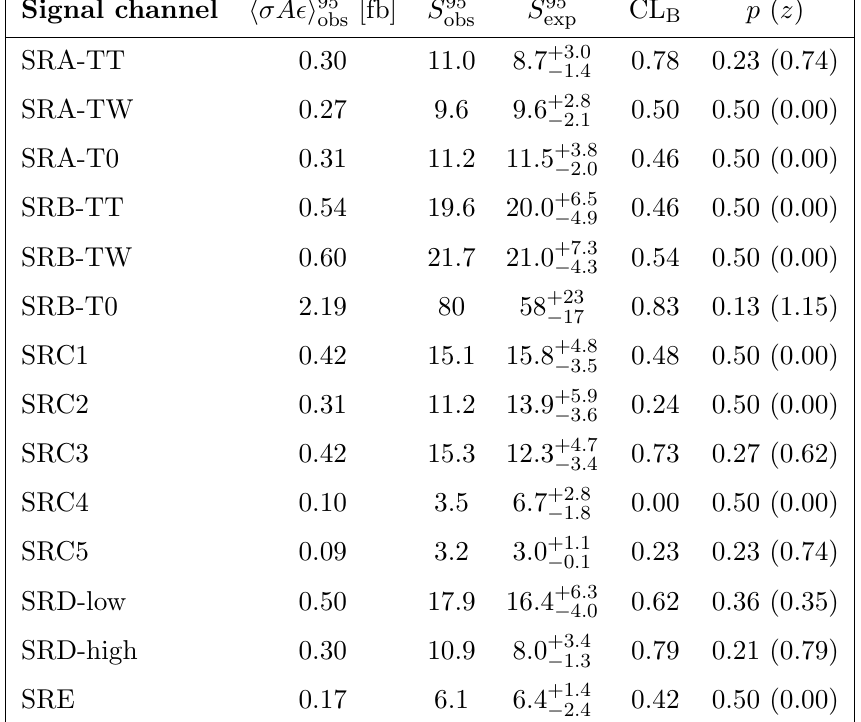
Table 14. Left to right: 95% CL upper limits on the average visible cross section ( h (cid:27)A(cid:15) i 95 where the average comes from possibly multiple production channels and on the number of signal ) shows the 95% CL upper limit on the number of signal events ( S 95 ). The third column ( S 95 exp obs events, given the expected number (and (cid:6) 1 (cid:27) excursions of the expected number) of background events. The two last columns indicate the CL B value, i.e. the con(cid:12)dence level observed for the background-only hypothesis, and the discovery p -value ( p ) and the corresponding signi(cid:12)cance ( z